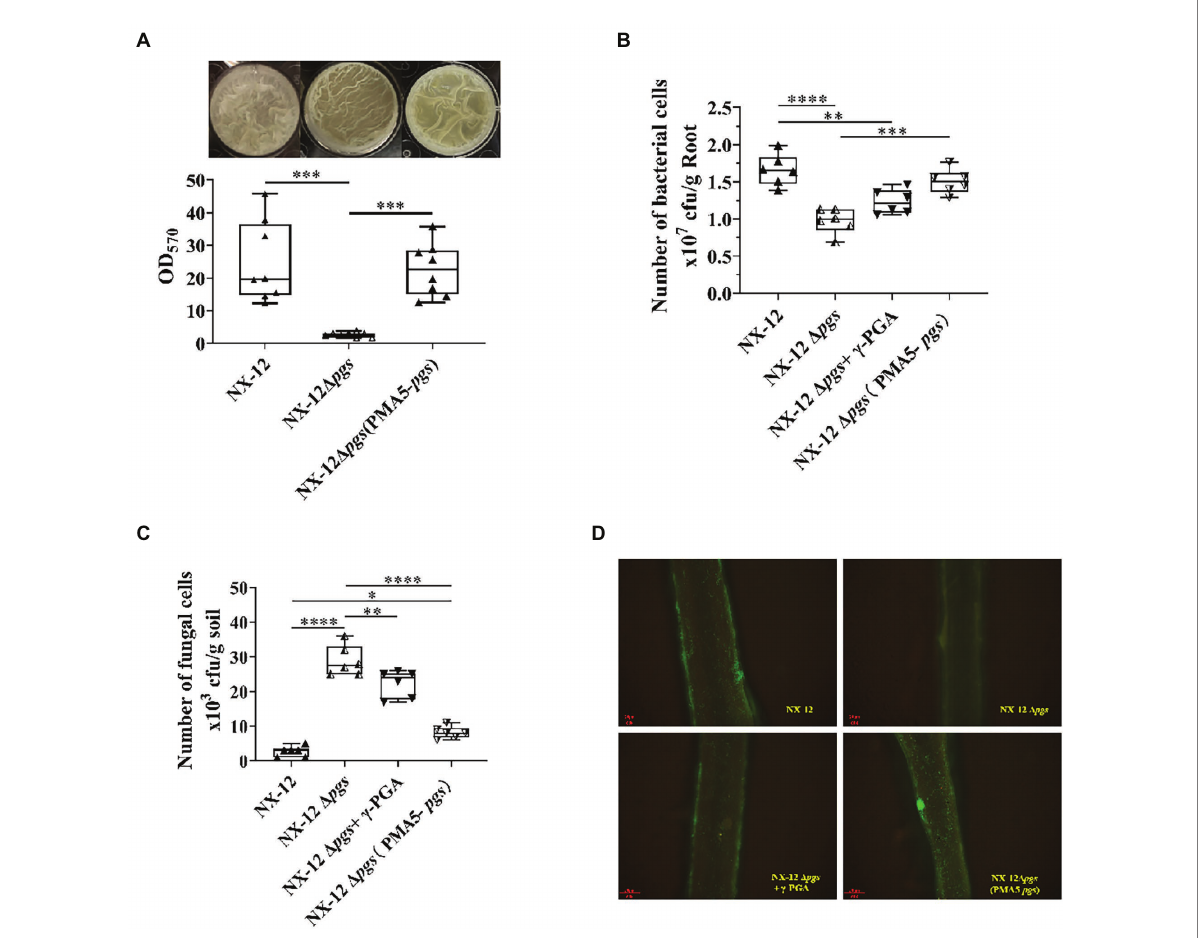
γ -PGA helps colonize and control pathogens. (A) Difference in biofilm formation between NX-12 and NX-12 Δ pgs in vitro ; (B) Number of bacteria cells colonized on the root surface of cucumber under the treatments of NX-12, NX-12 Δ pgs , NX-12 Δ pgs + γ -PGA, and NX-12 Δ pgs (pMA5- pgs ); (C) Number of fungal cells colonized on the root surface of cucumber under the treatments of NX-12, NX-12 Δ pgs , NX-12 Δ pgs + γ -PGA, and NX- 12 Δ pgs (pMA5- pgs ); (D) Colonization of fluorescent strains in the rhizosphere. Error bars represent standard deviations. * indicates value of p < 0.05; ** indicates value of p < 0.01; *** indicated value of p < 0.001; **** indicates value of p <